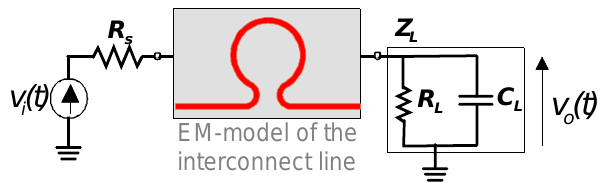
Figure 4: Schematic diagram used for the EM/circuit